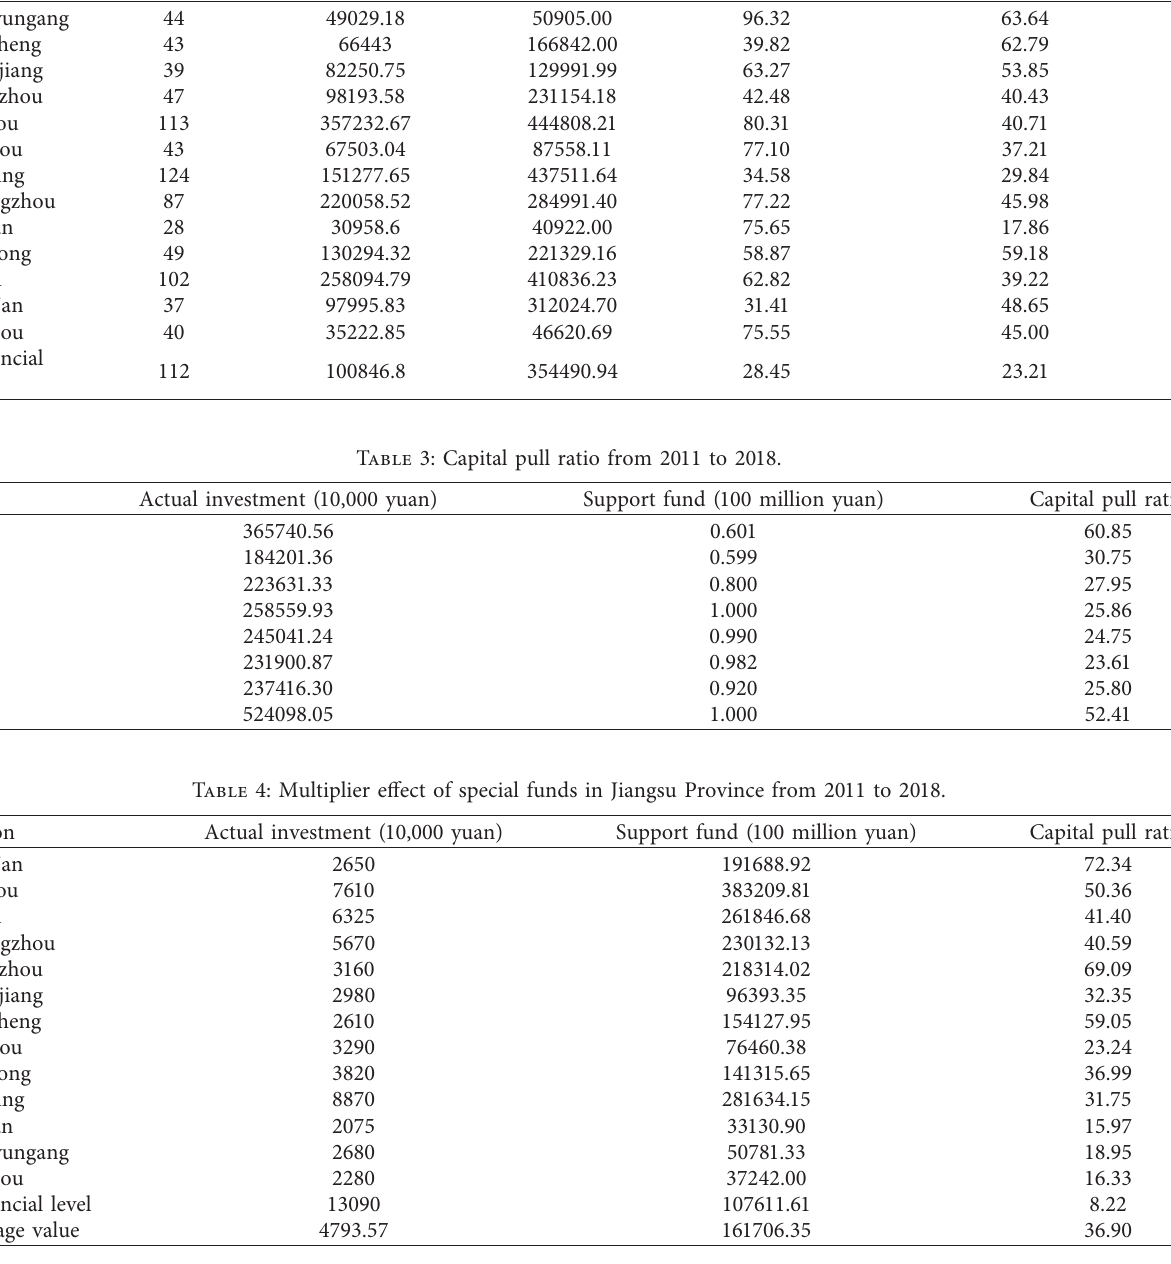
Table 2: Capital availability rate of various regions from 2011 to 2018 (data from Jiangsu Sports Industry Guidance Center). Region